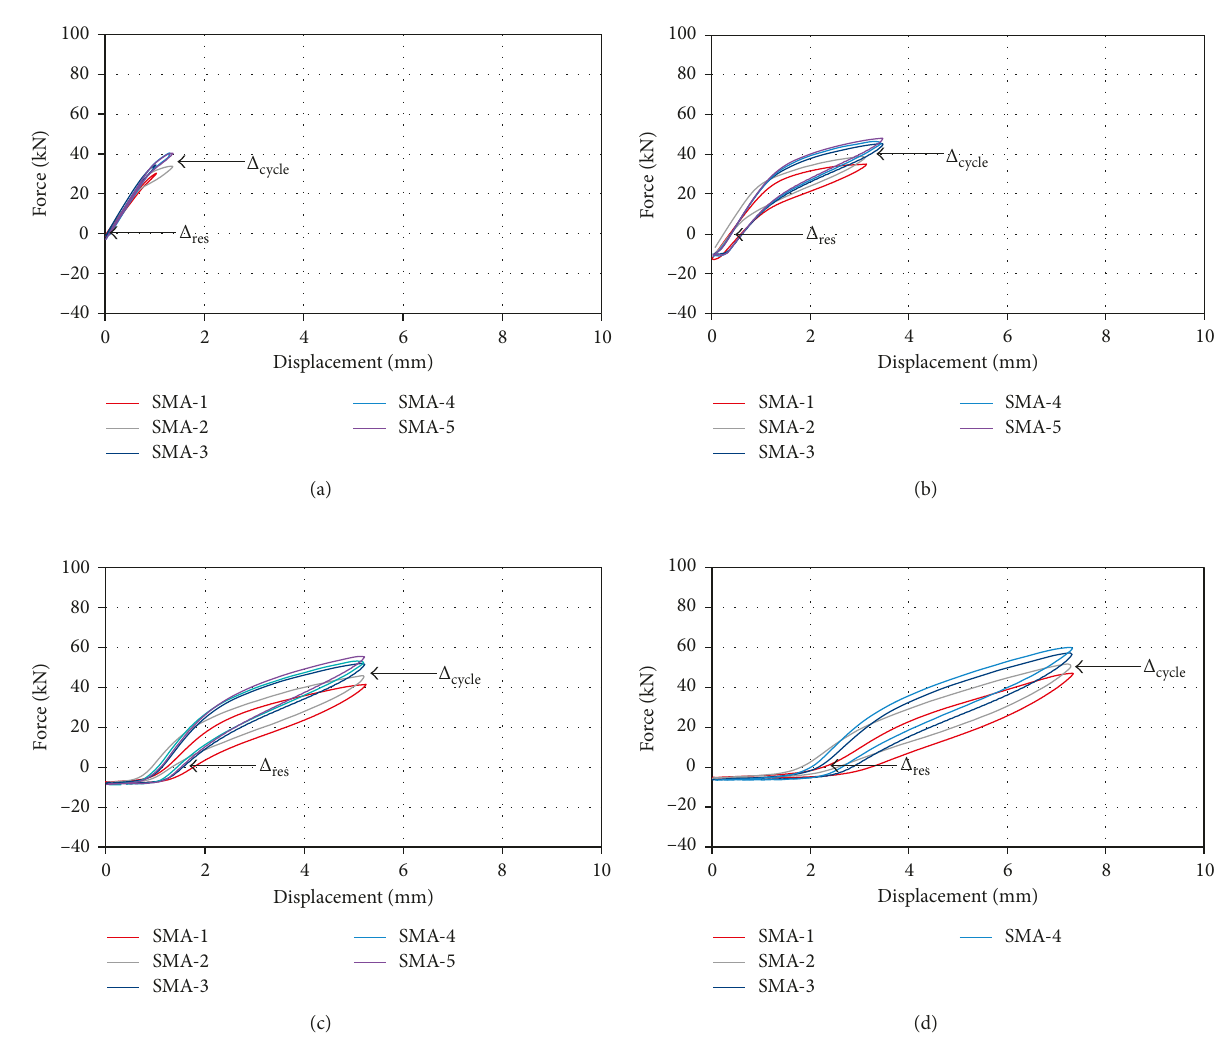
Figure 17: Force and displacement curves during loading cycles: S1 (1 mm) (a), S2 (3mm) (b), S3 (5mm) (c), and S4 (7mm) (d) loading